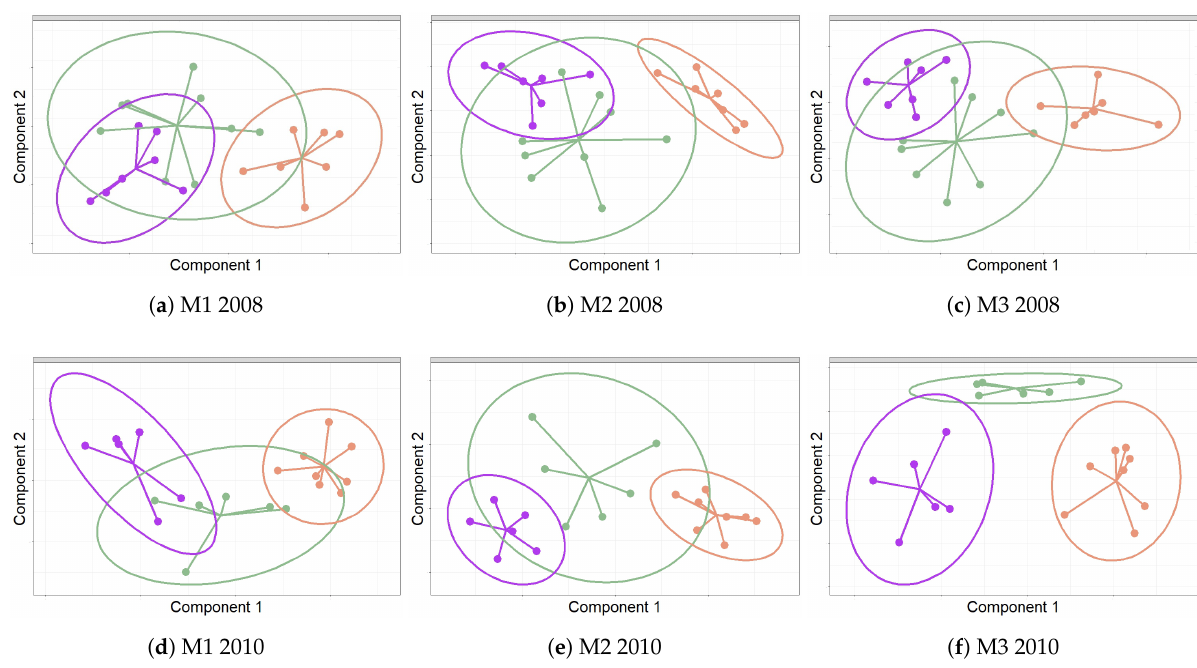
Figure 10. Discrimination of the time series of RH according to the position of sensors: Frescoes ( F ), Cornice and Ribs ( RC ), and Wall ( W ). Color codes: F sensors are shown in green, RC in orange, and W in purple. Graphics correspond to the projection of sensors over the first two components from sPLS-DA. Each graph shows confidence ellipses for each class to highlight the strength of the discrimination at a confidence level of 95%.